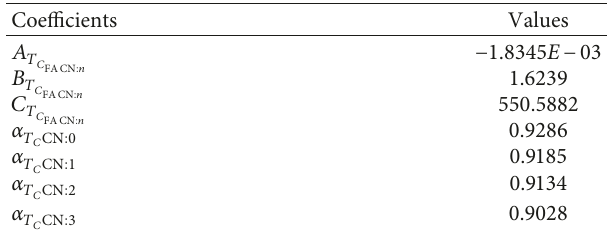
Table 19: Coefficients for the estimation of the critical pressure according to equation (37).